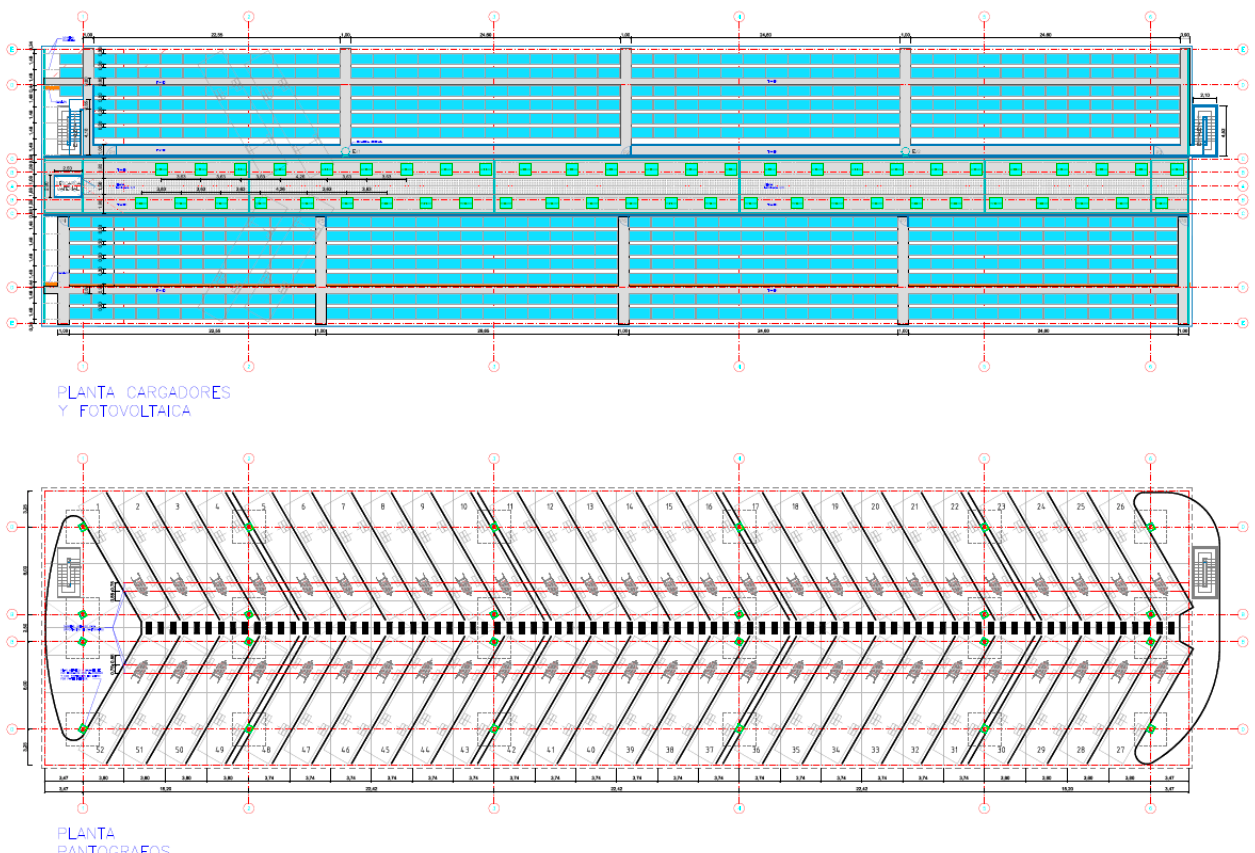
Figure 7. Distribution of inverted pantographs under construction for 25 buses of 12 m lenght e-buses in Carabanchel OC (Madrid).